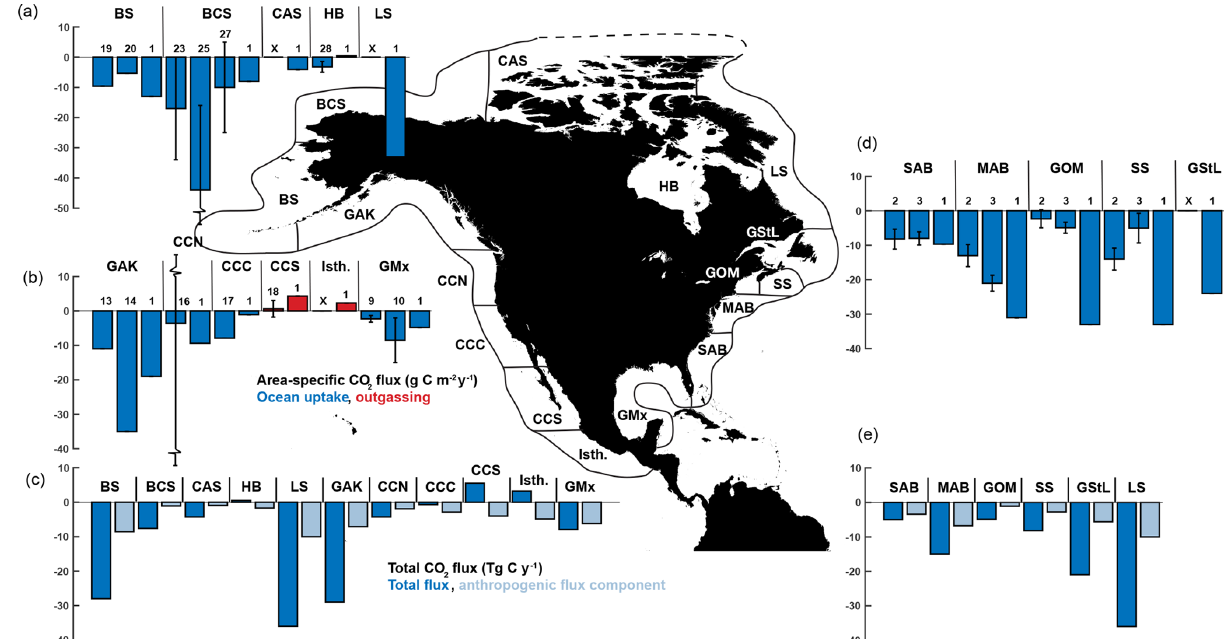
Figure 4. North American continent with EEZ decomposition (indicated by black outlines). Selected area-specific regional CO 2 flux esti- mates from Fig. 2 are shown in comparison to the global model estimates (referred to as 1) in (a, b, d) (see Fig. 2 for reference key). “X” indicates that no regional estimate is available. Total CO 2 flux estimates from the global model and the anthropogenic components are shown in (c, e) . Subregion abbreviations are MAB – Mid-Atlantic Bight, GOM – Gulf of Maine, SS – Scotian Shelf, GStL – Gulf of St.